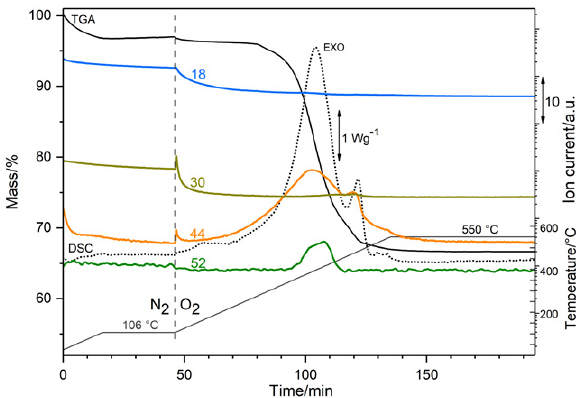
Figure 4. Simultaneous TGA–DSC–MS analysis of the residue of the T1H100 sample up to 550